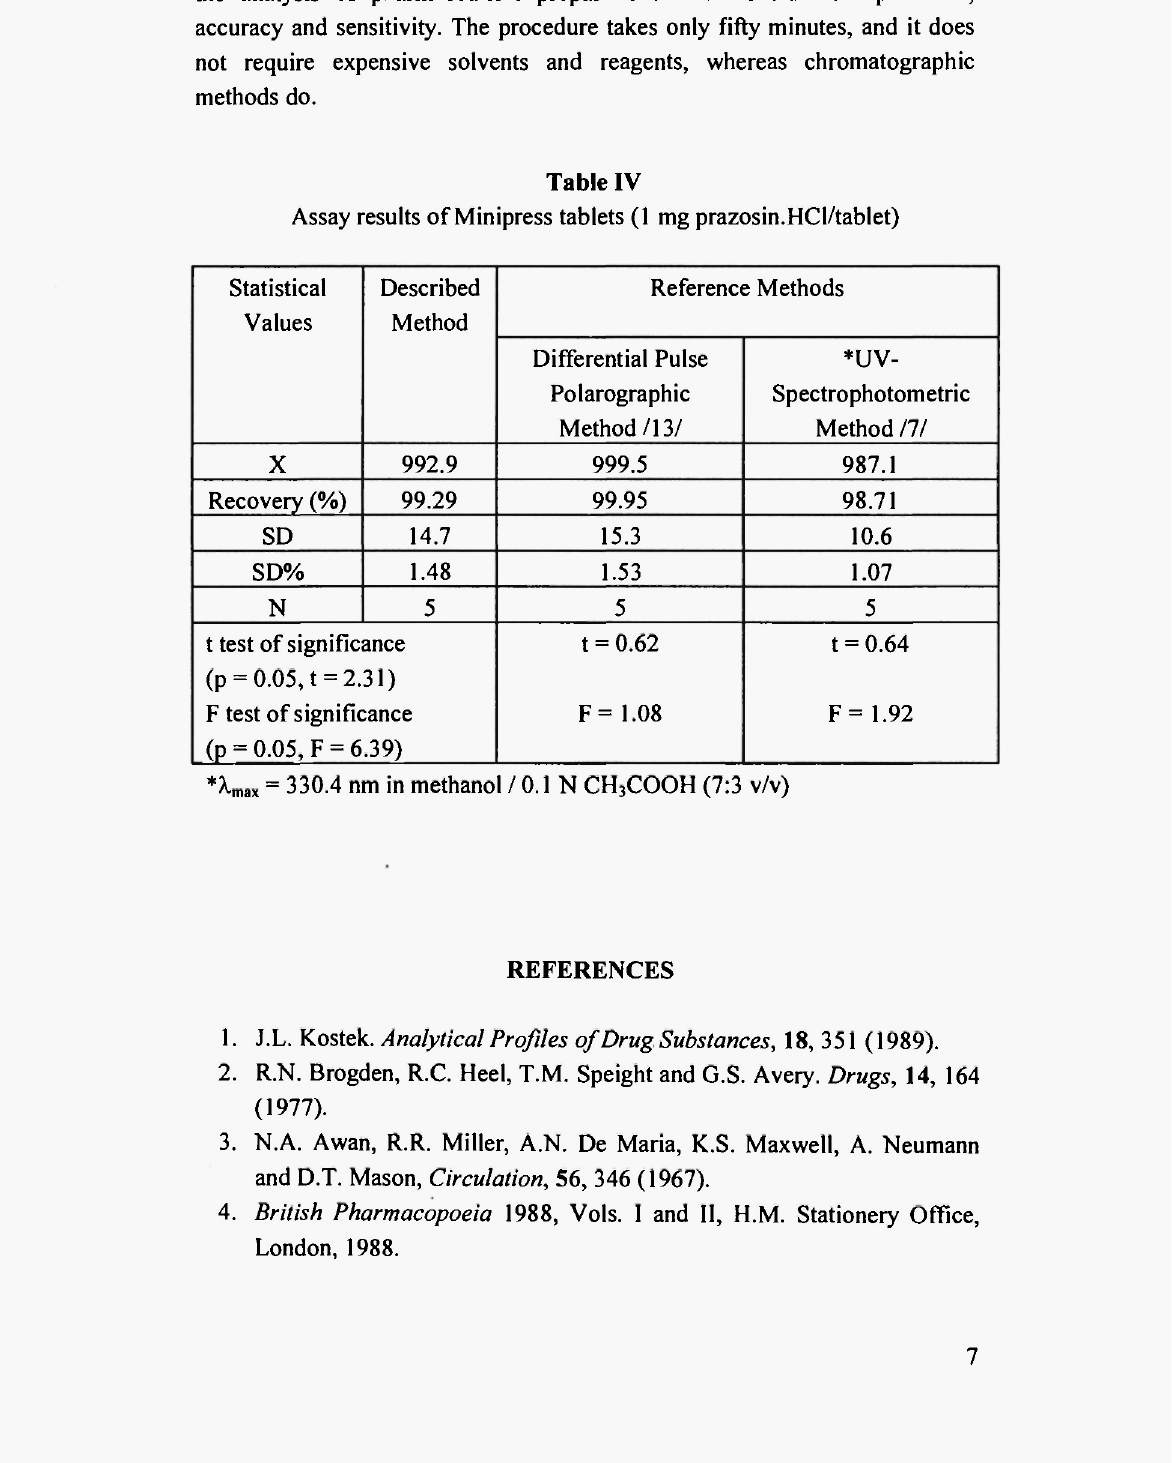
Assay results of Minipress tablets (1 mg